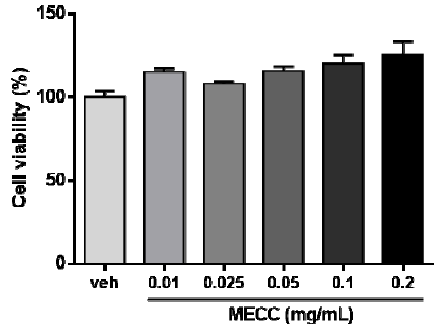
Figure 1. Effects of methanol extract of Cajanus cajan L. leaves (MECC) on cell viability in HepG2 cells. HepG2 cells were cultured in LPDS medium and treated with vehicle (0.1% DMSO) or MECC (0.01, 0.025, 0.05, 0.1 and 0.2 mg/mL) for 24 h. The cell viability was measured by MTT assay, and the data were presented as the means ± SD from three independent experiments.